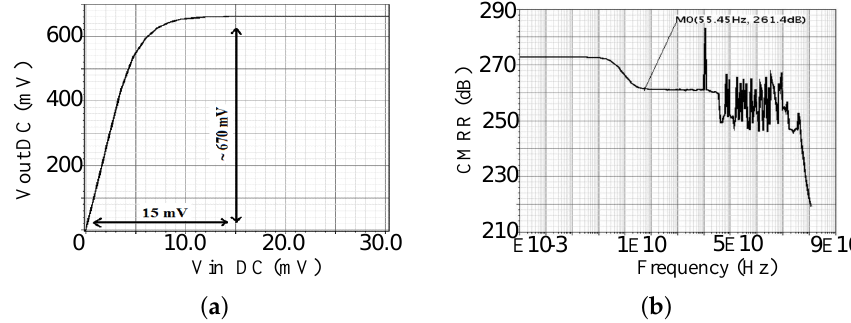
Figure 9. ( a ) Simulated Transfer Function of the CLPGA; and ( b ) bode transfer function of the simulated CMRR.